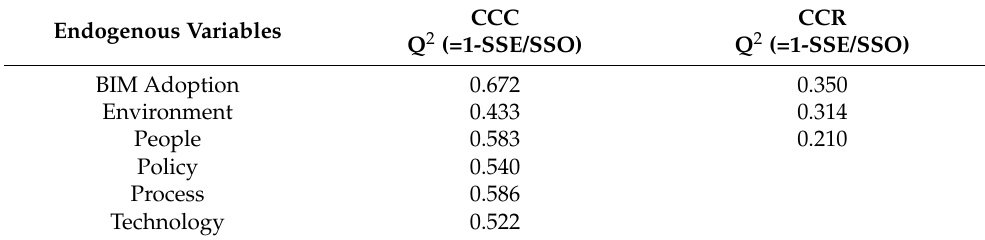
Table 11. Predictive Relevance Results.